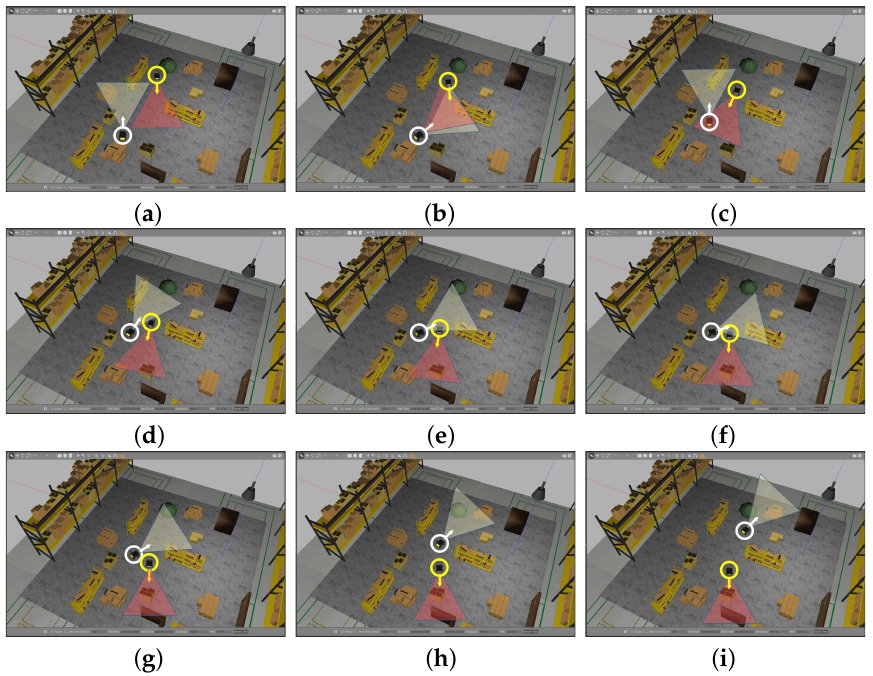
Figure 12. Snapshots of Gazebo [33] environments, where Husky1 is labeled with a white colored circle and Husky2 is labeled with a yellow colored circle. ( a – i ) are time-sampled snapshots depicting the motions of Husky1 and